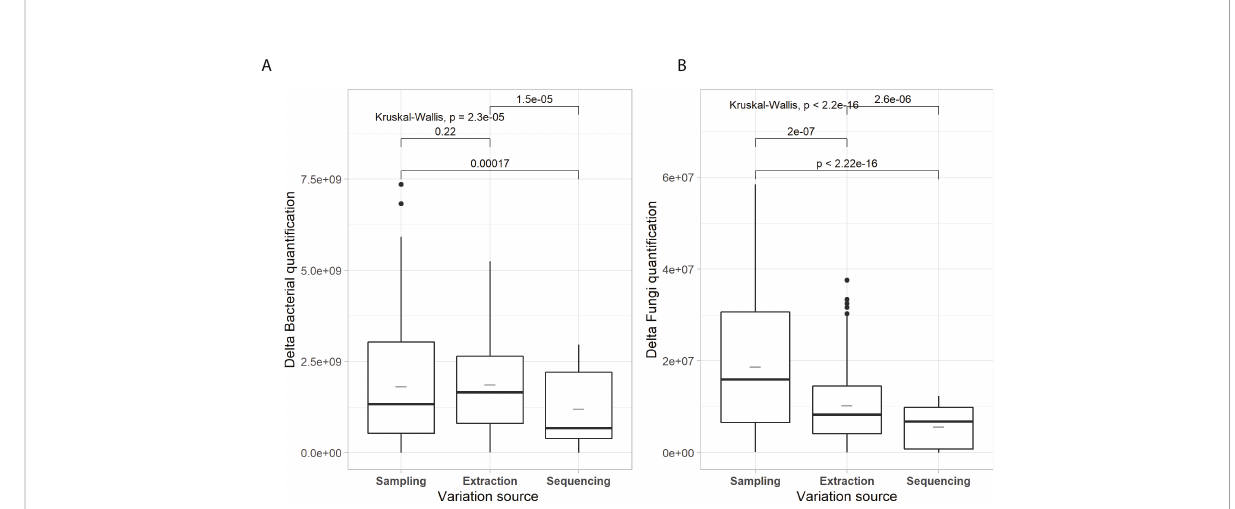
FIGURE 2 Box-and-whisker plots of microbial quanti fi cation for each component of technical variability for prokaryotic (A) and fungal (B) communities. Boxplots are the same format as those described in Figure 1. Kruskal-Wallis tests with post hoc pairwise Wilcoxon-test comparisons follow a similar format to Figure